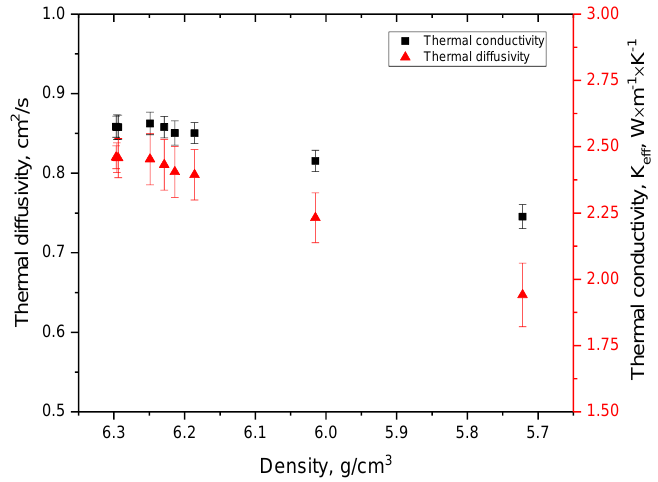
Figure 11. Dependence of the change in thermophysical parameters on the change in the density of ceramics.